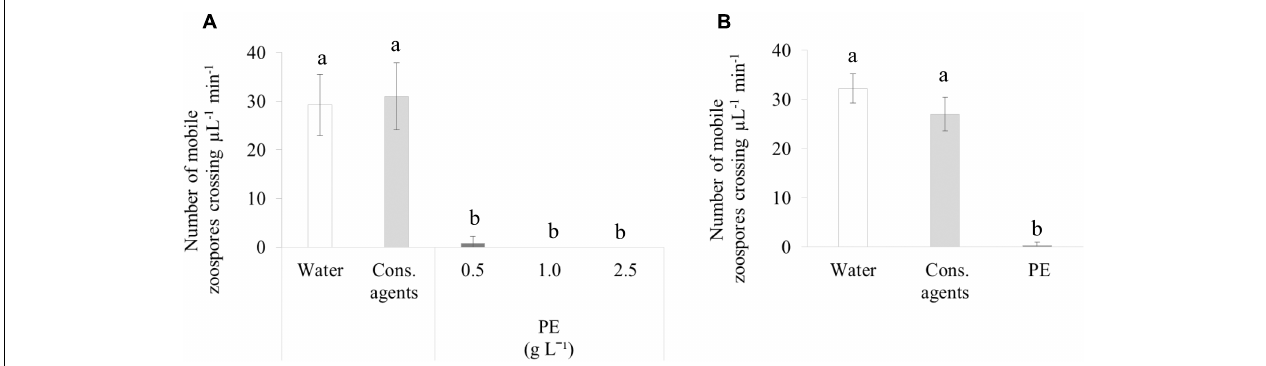
FIGURE 7 | In vitro assessment of direct effect of PE on P. viticola . (A) Release of zoospores from sporangia at 2 hpt. (B) Motility of zoospores already released at 2 min post treatment. Sporangia were collected from a sporulating leaf and concentrated at 10 5 sporangia mL − 1 , then PE was applied at different concentrations. As controls, cons. agents or water were added (volumes corresponding to the highest concentration of PE). Motile zoospores crossing one unit of Malassez hemacytometer were counted during 1 min. Results correspond to the mean ± confidence interval of three independent biological repetitions, with three technical repetitions each. Significant differences ( p ≤ 0.05) were identified with Kruskal–Wallis coupled with Dunn’s multiple comparison test. Conditions with different letters are significantly different.